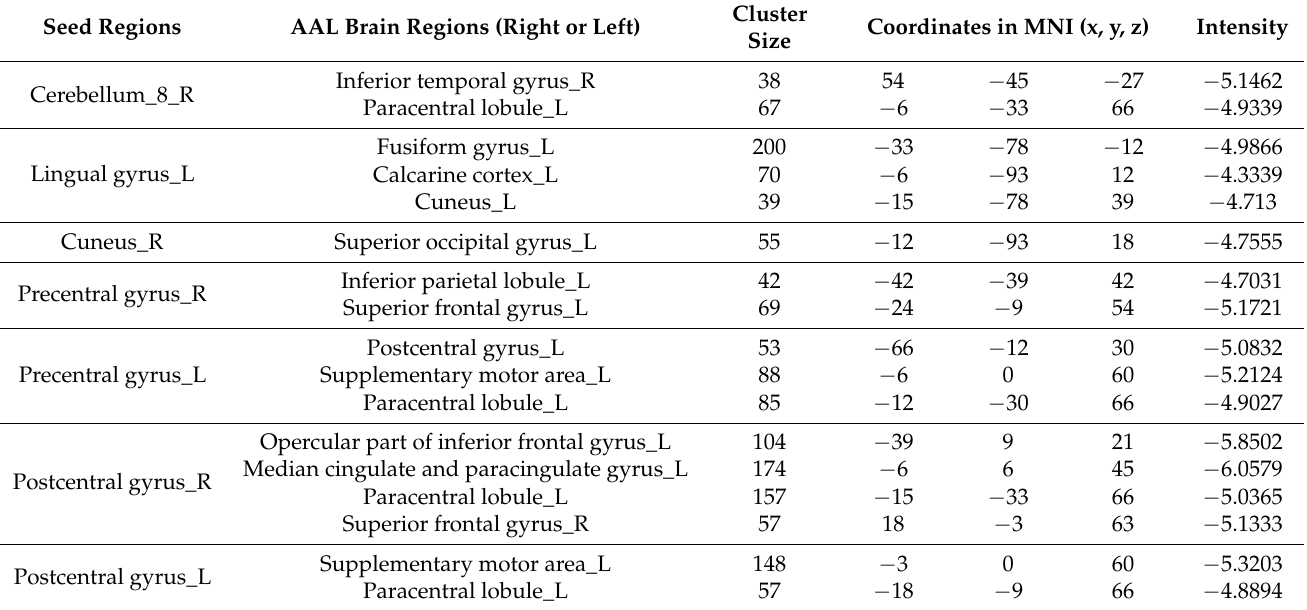
Table 3. Brain regions with decreased seed-based FC in MwoA patients relative to HCs.